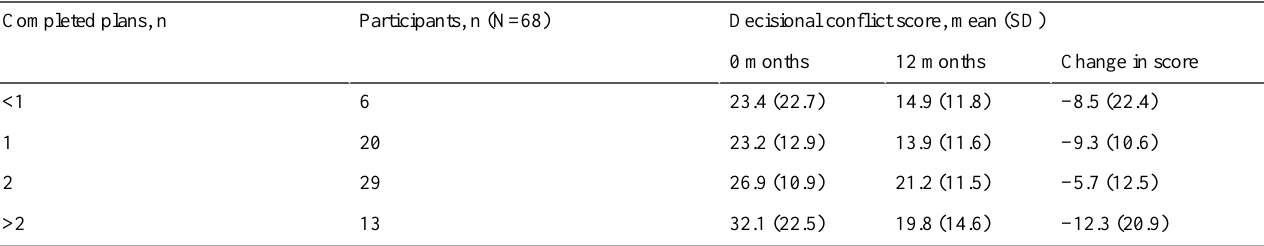
Table 4. Change in decisional conflict over 12 months in the intervention group using MyDiabetesPlan by number of completed